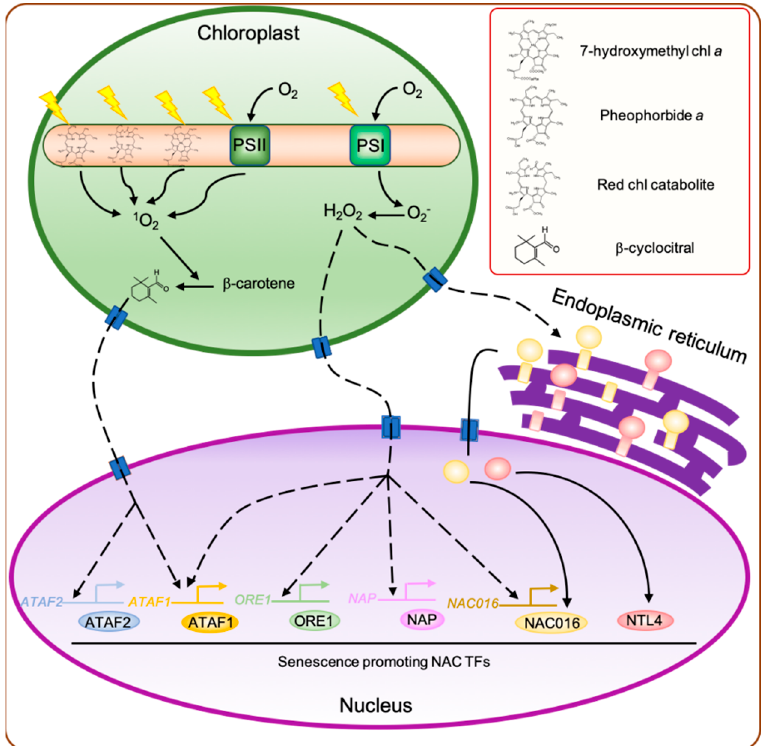
Figure 1. Regulatory network of leaf senescence induced by chloroplast-derived retrograde signaling. During the senescence phase, the abundance of photosystem proteins decreases significantly. Consequently, the captured light energy exceeds the amount needed by the remaining photosynthetic units, leading to the production of a large amount of O 2 − by photosystem I (PSI) and 1 O 2 by PSII. In addition, the dismantling of light harvesting complex II (LHCII) proteins releases a large number of chlorophyll molecules and their degradation products, such as 7-hydroxymethyl chlorophyll a , pheophorbide a , and red chlorophyll catabolite, which act as photosensitizers, producing high amounts of 1 O 2 in the presence of light. The 1 O 2 generated in chloroplasts promotes the cleavage of β -carotene to produce β -cyclocitral, which then acts as a retrograde signal between the chloroplast and nucleus to activate the expression of 1 O 2 -responsive genes, including senescence-associated Arabidopsis thaliana activating factor (ATAF) subfamily no apical meristem /ATAF1,2/ cup-shaped cotyledon (NAC) genes, ATAF1 and ATAF2 . O 2 − generated by PSI is rapidly dismutated into H 2 O 2 , which acts as a signaling molecule to alter the expression of H 2 O 2 -responsive genes, including ATAF1 , ORESARA1 ( ORE1 ), NAC- like, activated by AP3/PI ( NAP ), and ANAC016 . In addition, H 2 O 2 generated in the chloroplasts also triggers the translocation of membrane-bound NAC transcription factors (TFs), such as ANAC016 and NAC with transmebrane motif 1-LIKE4 (NTL4), from the endoplasmic reticulum to the nucleus. Dashed arrowheads indicate the indirect activation of genes. chl, chlorophyll.